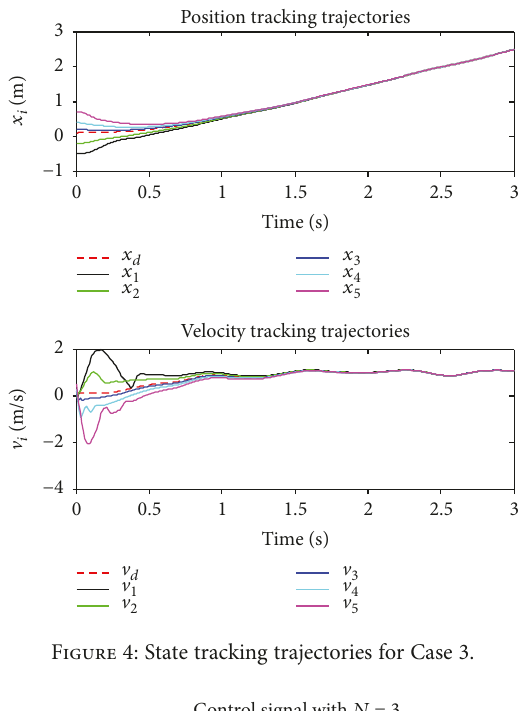
Figure 3: State tracking trajectories for Case 2.